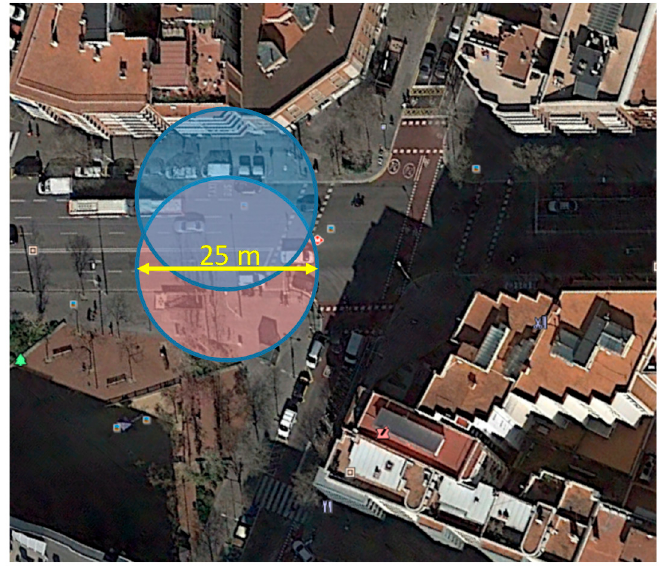
Figure 6. Cell coverage.